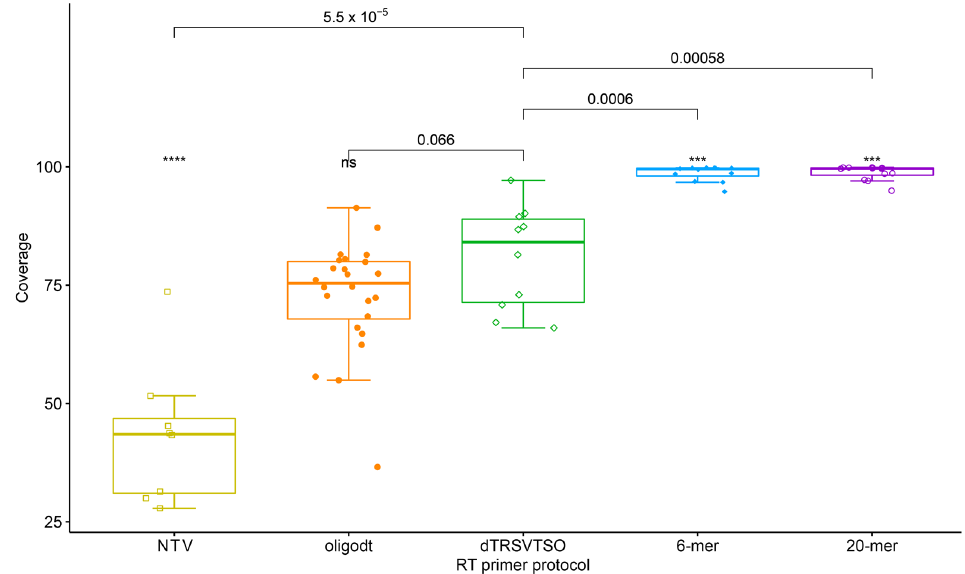
Figure 3. Comparison of reads mapped to the TRSV genome after HTS of libraries generated with the TASPERT, OligodT, random 6-mer, and 20-mer RT primers. NTV is the reference negative control.